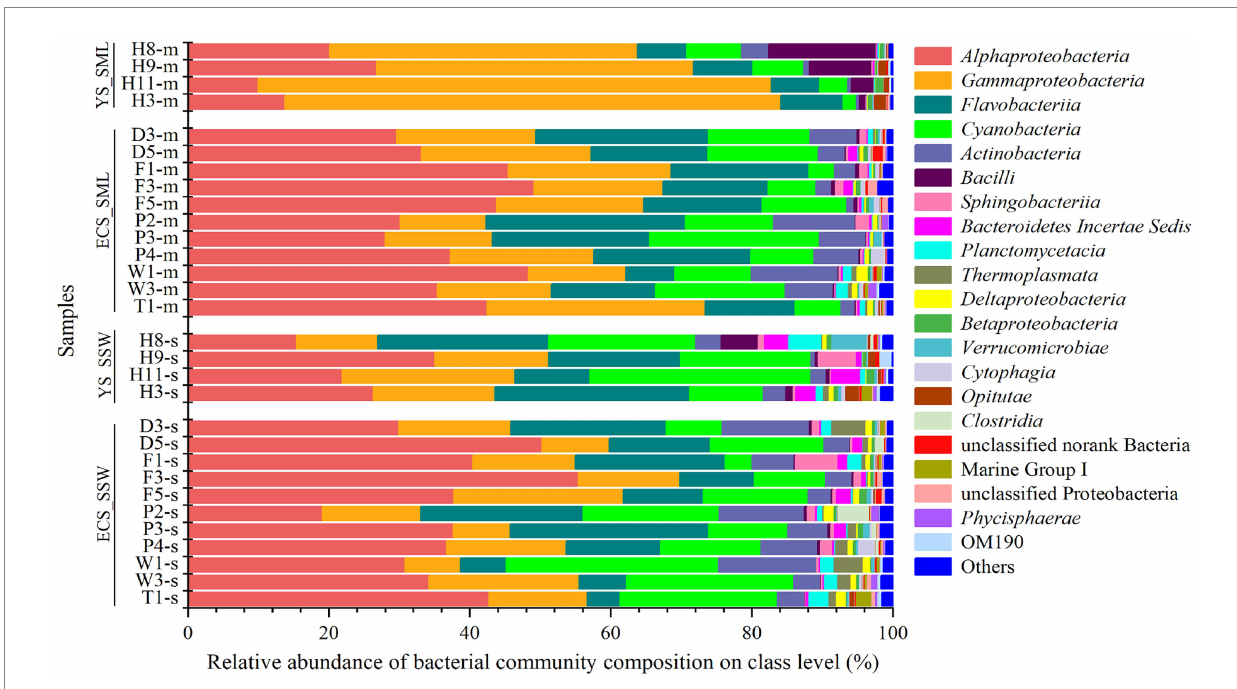
FIGURE 3 The bacteria community of SML and SSW in the eastern China marginal seas in summer. The SML and SSW samples are indicated by “m” or “s” in their sample names, respectively. YS_SML, the Yellow Sea SML samples; ECS_SML, the East China Sea SML samples; YS_SSW, the Yellow Sea SSW samples; ECS_SSW, the East China Sea SSW samples.